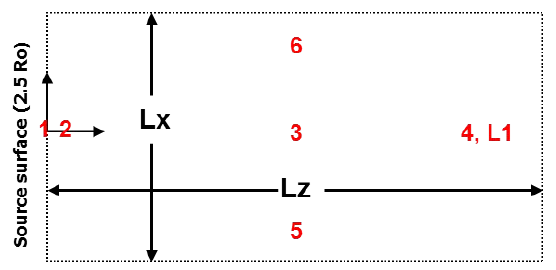
Fig. 1. Sketch of the domain simulated with FLIP-MHD. The left boundary corresponds to the source surface, conventionally located at 2.5 solar radii. The right boundary is placed at the terrestrial at- mosphere. L x and L z are the box size in the x and z directions. The red numbers mark the diagnoses locations, as explained in Sect.